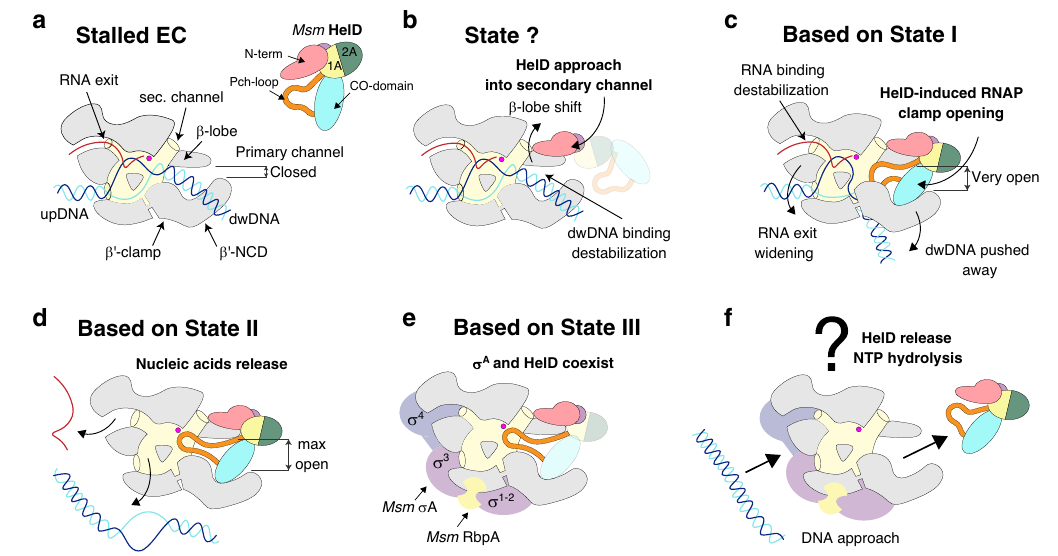
Fig. 5 A model of the HelD functioning in RNAP recycling. a When EC stalls, it needs to be disassembled. b The HelD N-terminal domain (pink) fi rst approaches the RNAP secondary channel and then induces changes in RNAP likely destabilizing the RNAP-dwDNA interaction. c Subsequent interactions of the HelD PCh-loop (orange) and the whole HelD-speci fi c domain (cyan) in the RNAP primary channel open the RNAP cleft, widen the RNA exit channel and mechanically interfere with dwDNA. d An even broader cleft/RNA exit opening together with the PCh-loop intervening deep in the AS (MgA, magenta sphere) displace dwDNA and the RNA/DNA hybrid from the active site cavity. e The HelD – RNAP nucleic acid-free complex binds σ A factor and RbpA, and all factors can bind RNAP core simultaneously. f The complex binds to DNA promoter via the σ A factor with a concomitant displacement of HelD from RNAP by an unknown mechanism, possibly dependent on NTP hydrolysis by HelD and a new round of σ A -dependent transcription cycle can